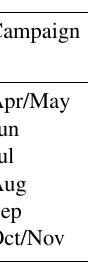
Table 4. Arctic-CAP 2017 campaign